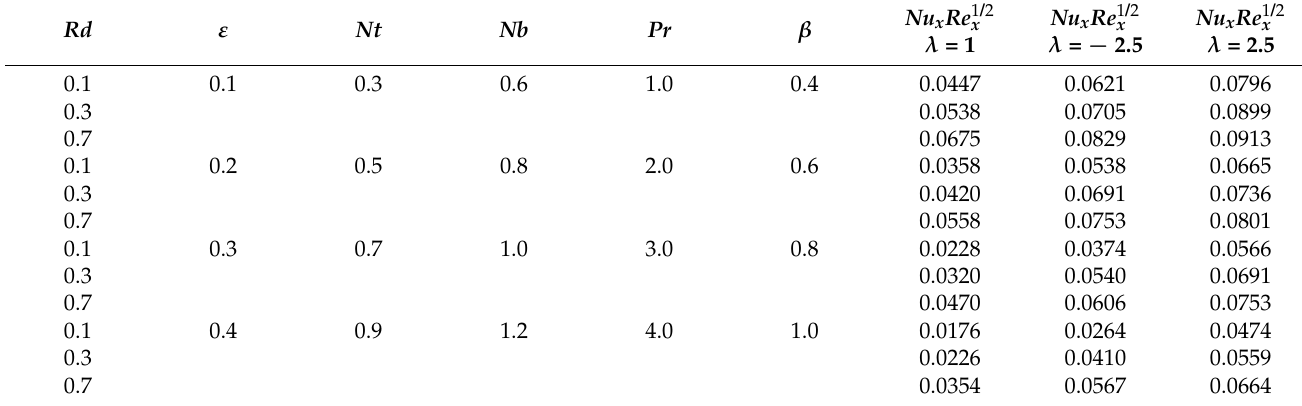
Table 3. Nusselt number for various physical variables.